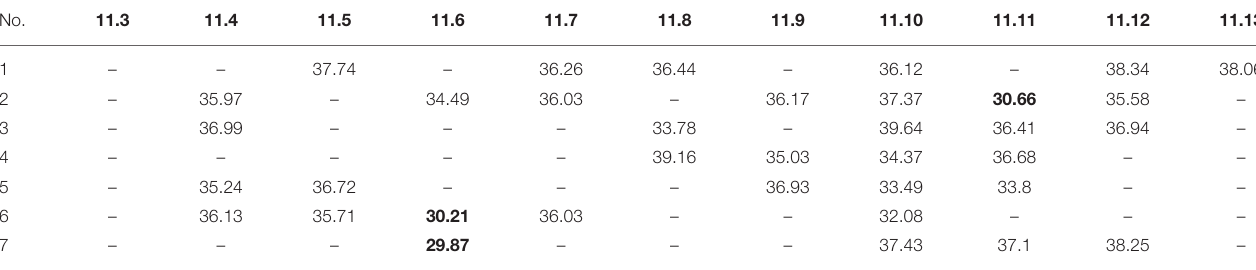
TABLE 3 | Monitoring results of continuous virus shedding of diseased sows.